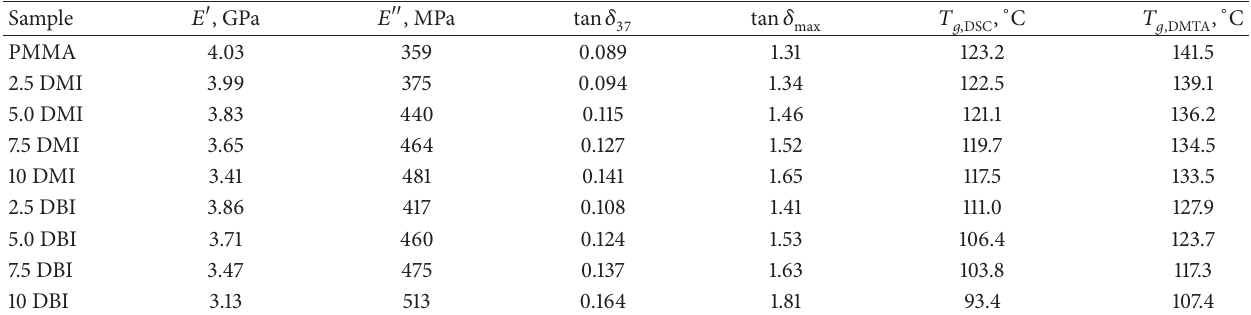
Figure 5: DSC curves of PMMA denture base materials modified with (a) DMI and (b) DBI. Table 2: Storage modulus ( 𝐸 󸀠 ), loss modulus ( 𝐸 󸀠󸀠 ) and damping factor (tan 𝛿 37 ) at 37 ∘ C, maximal value for damping factor (tan 𝛿 ), and glass ) and DMTA ( 𝑇 𝑔, ) measurements for PMMA denture base materials modified with DMI transition temperatures obtained by DSC ( 𝑇 𝑔, DSC DMTA and